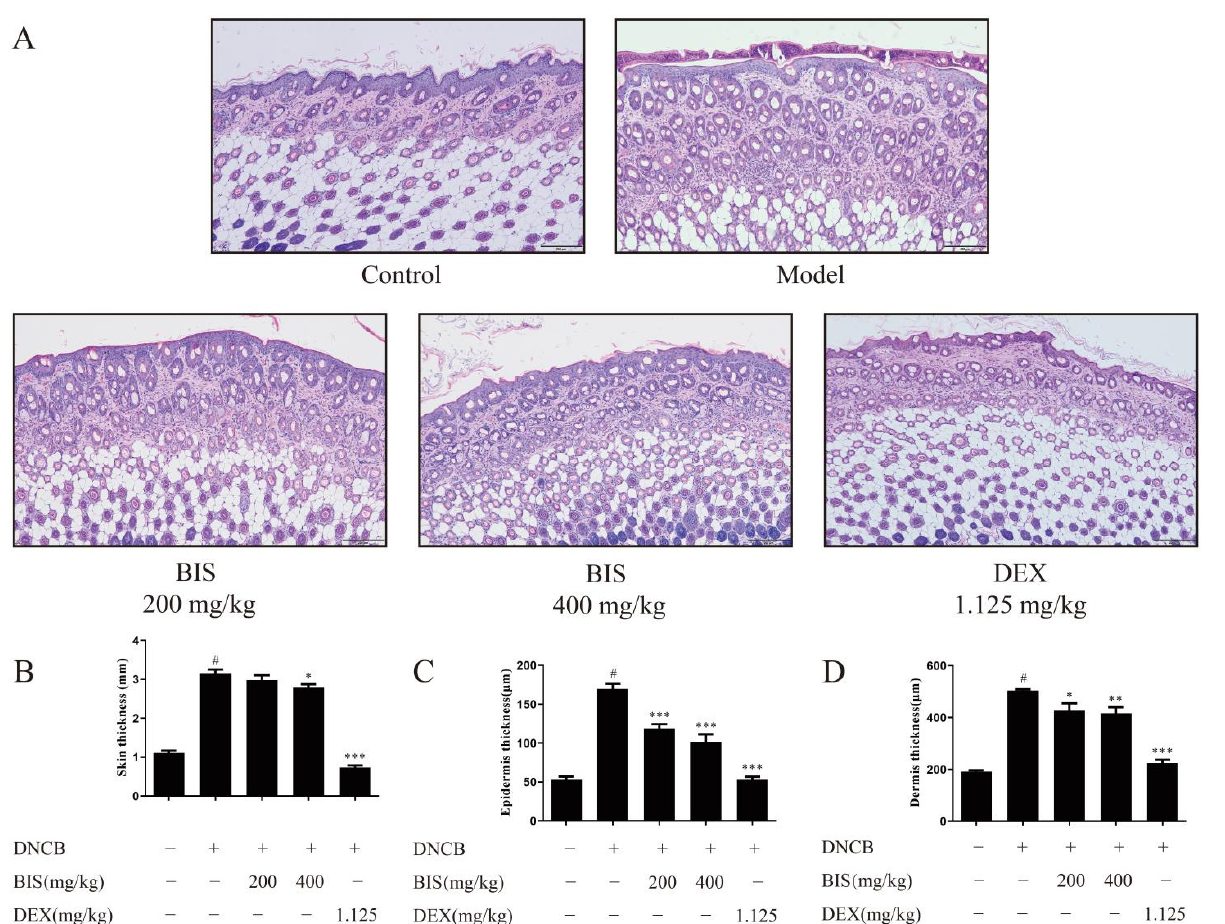
Figure 2. Effects of BIS on DNCB-induced skin thickness. ( A ) The representative images of dorsal skin stained with H&E. ( B ) Measurement of skin thickness by Vernier caliper. Epidermal thickness ( C ) and dermal thickness ( D ) were determined by H&E staining. Magnification: ×100. Scale bar, 200 µm. Data represent the mean ± SEM, n ≥ 5 mice/group. # p < 0.05 vs. Control; * p < 0.05, ** p < 0.01, *** p < 0.001 vs. Model.